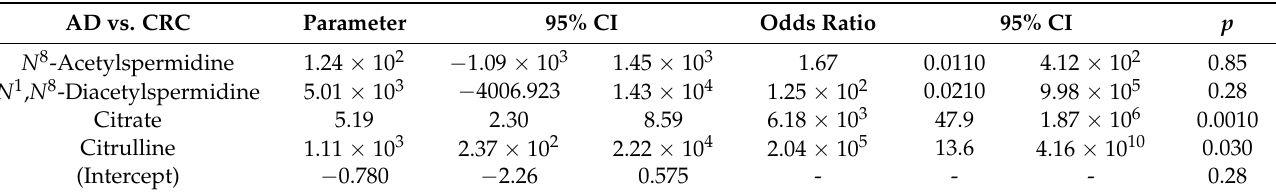
Table 3. MLR model to discriminate CRC from AD.